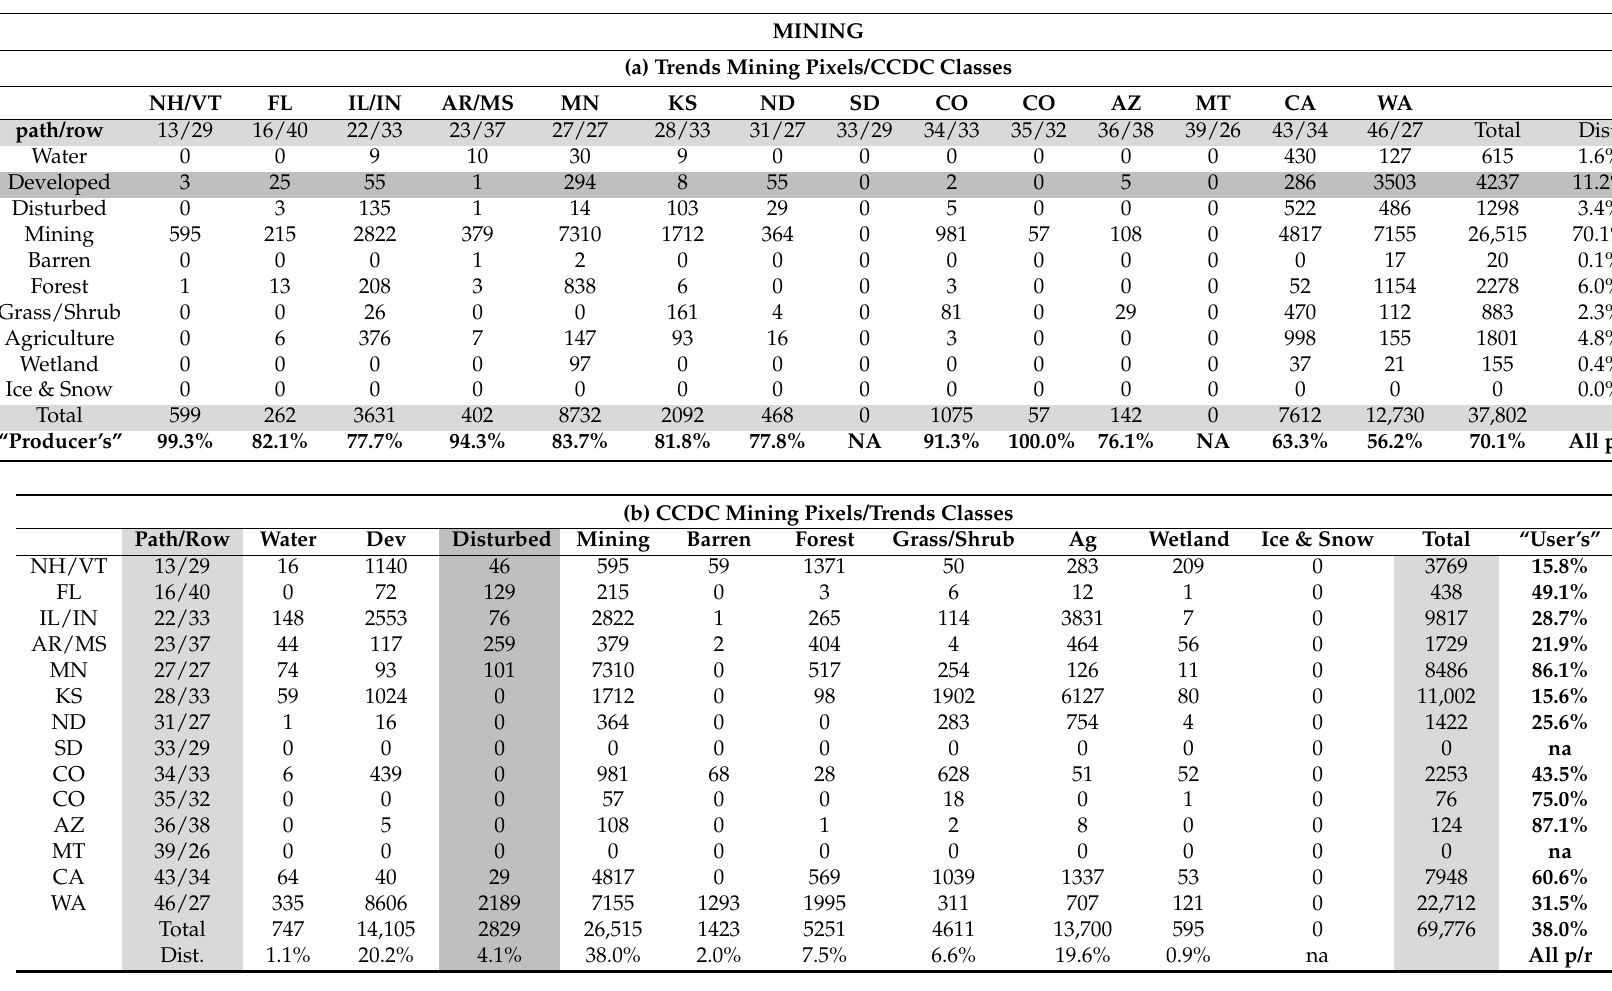
Table 12. (a) LC Trends Mining pixels distributed across CCDC classes for each path/row location and (b) CCDC Mining pixels distributed across LC Trends classes for each path/row. AR = Arkansas; AZ = Arizona; CA = California; CO = Colorado; FL = Florida; IL = Illinois; IN = Indiana; KS = Kansas; MN =